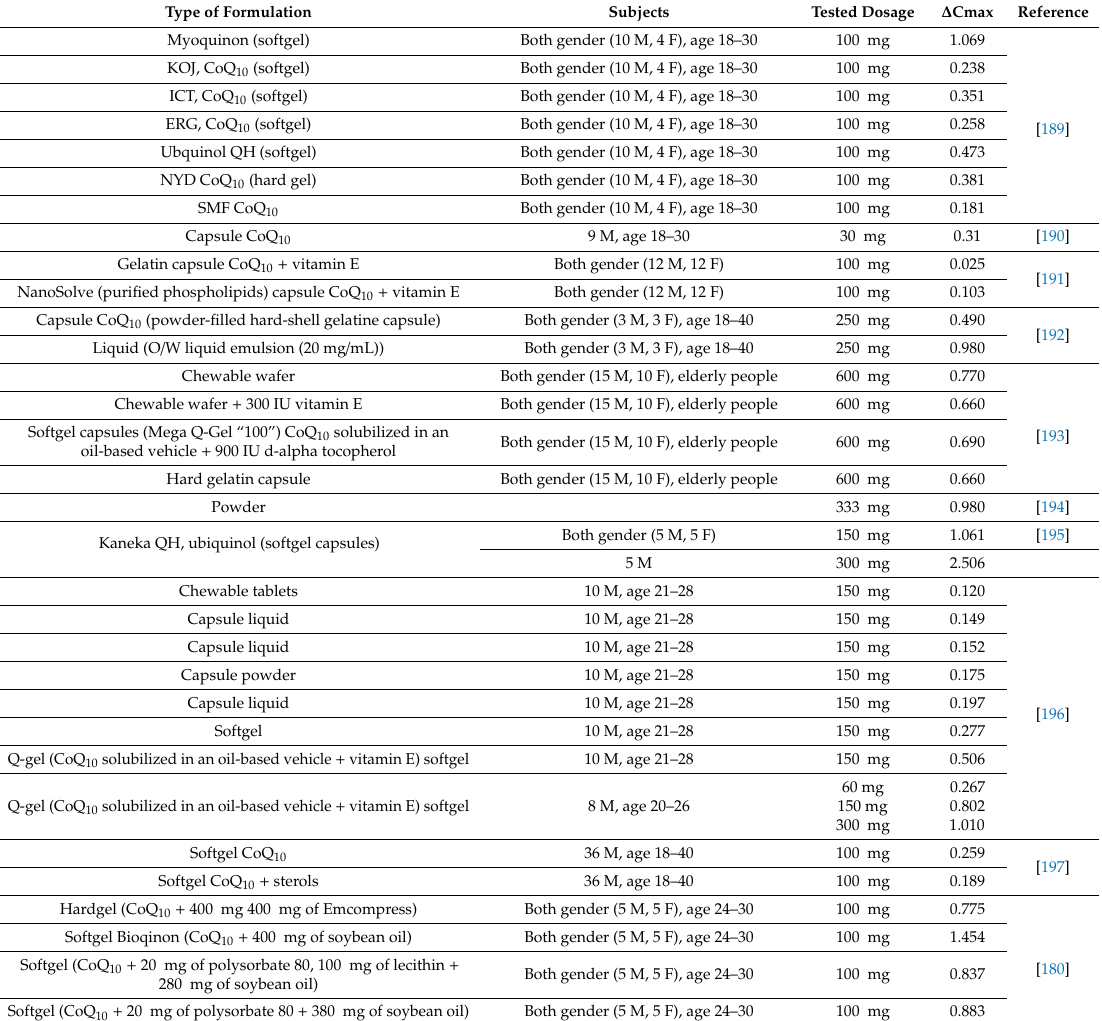
Table 3. Comparative study of ∆ C max after a single dose of di ff erent formulations of CoQ 10 (adapted from L ó pez-Lluch et al.